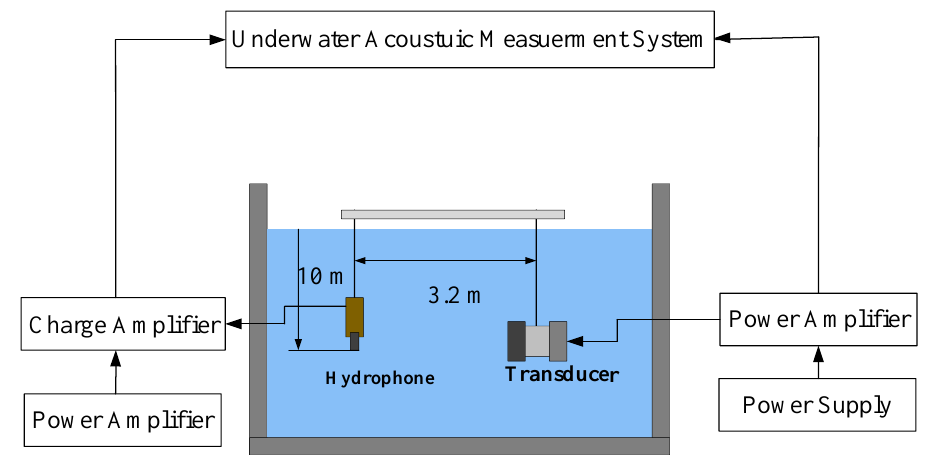
Figure 12. Schematic of underwater measurement system for transducer.